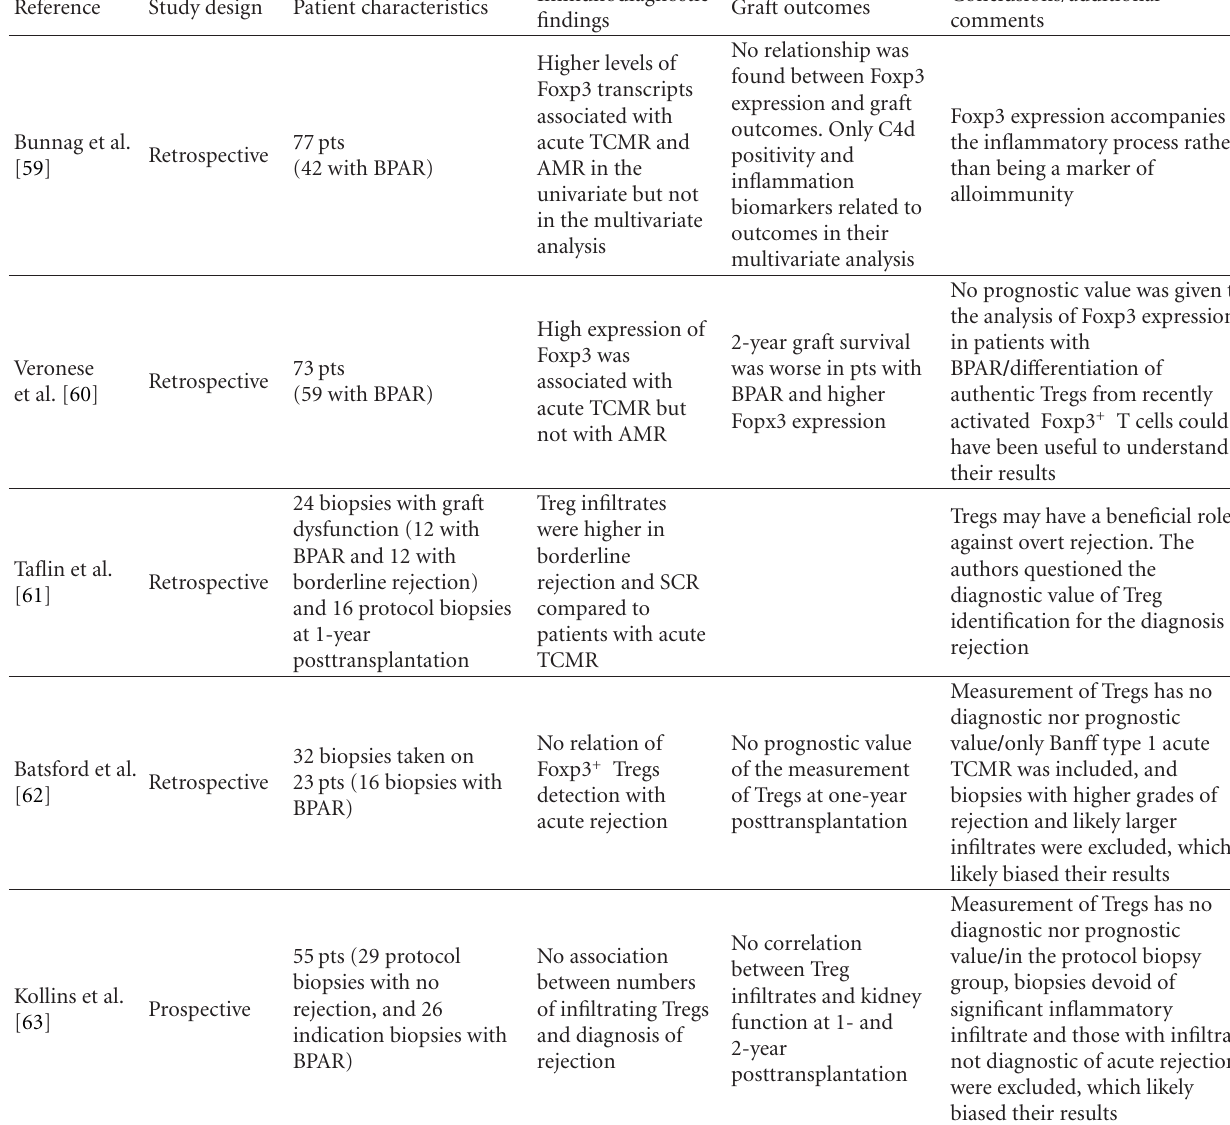
Table 2: Studies with conflicting results regarding the association of regulatory T cells with kidney rejection and graft outcomes